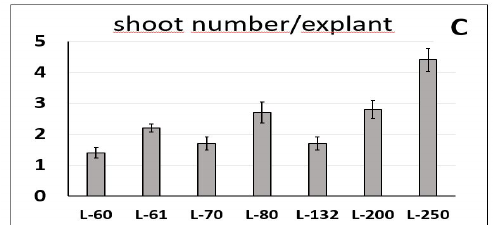
Figure 2. Effect of the genotype of six thorny artichoke lines ( Cynara scolymus L.) grown on multiplication medium (first subculture): (A) Shoot height (cm), (B) number of leaves, and (C) shoot number/explant. Values are means ± SE (n =